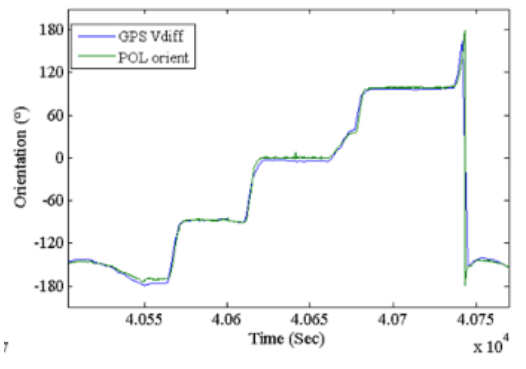
Figure 11. Comparison between GPS heading and results of the sensor